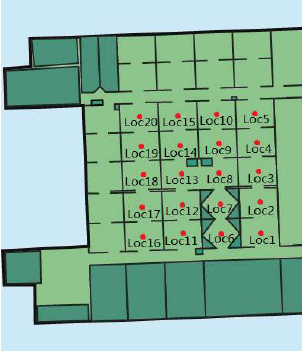
Figure 9. The sampling positions of Dataset2 in our laboratory.